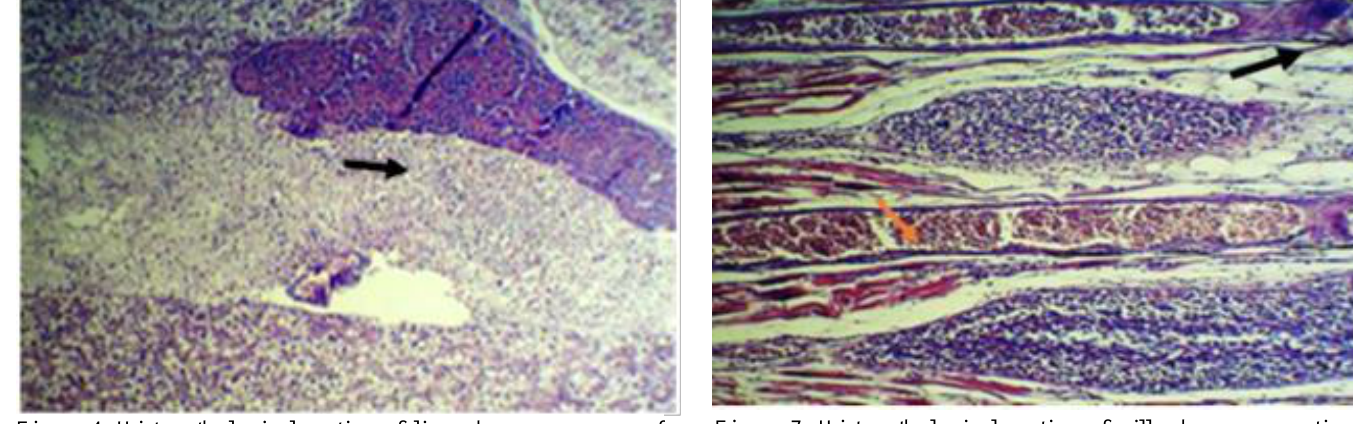
Figure 4. Histopathological section of liver shows presences of fibrin network with inflammatory cells infiltration between the liver parenchyma and hepatopancreas (